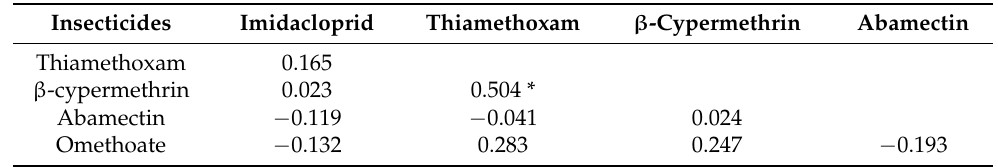
Table 6. Pair-wise correlation analysis of the LC 50 values of five insecticides for 19 Metopolophium dirhodum field